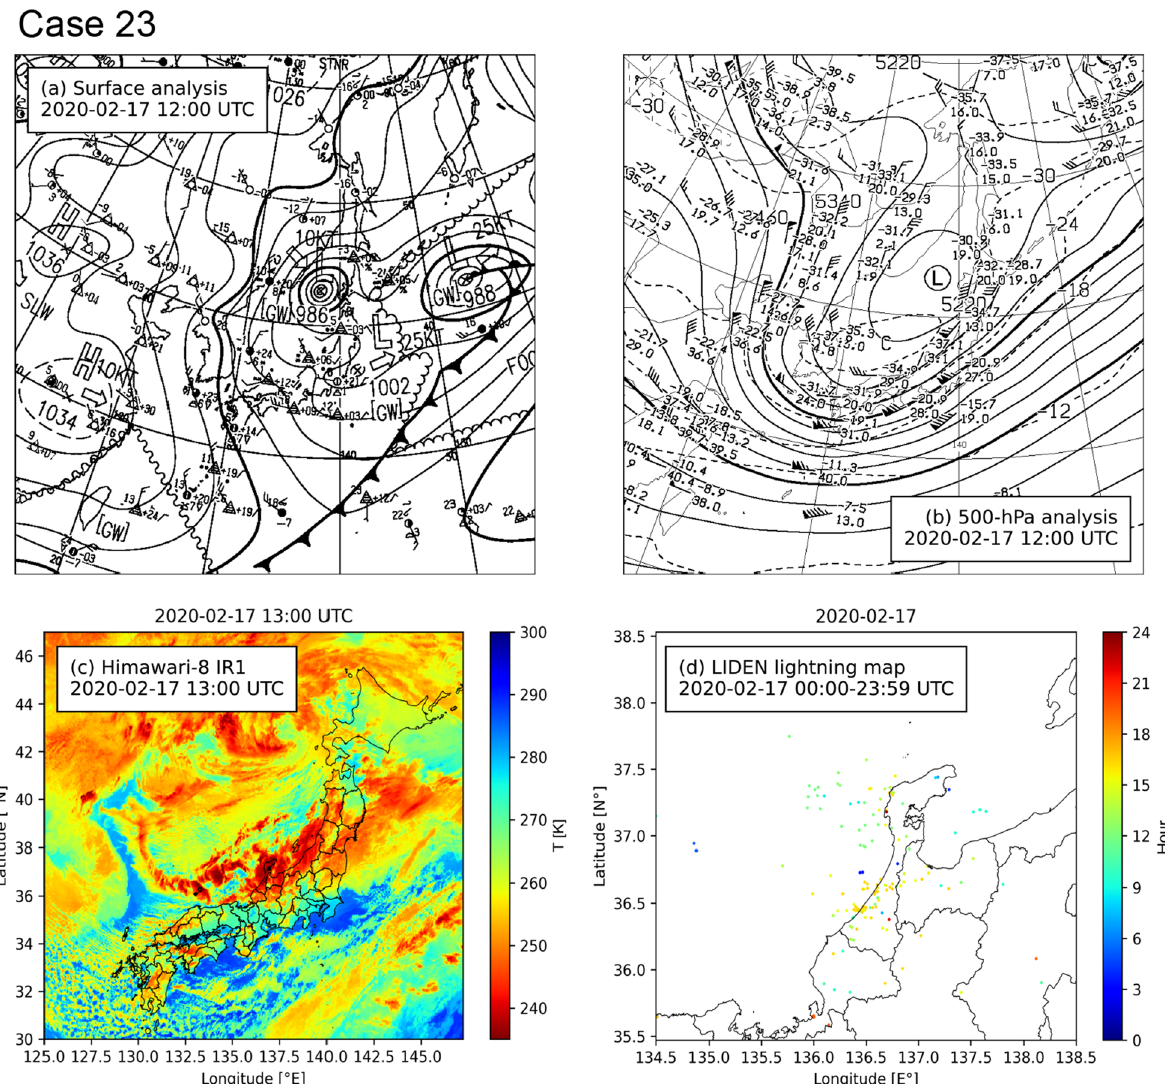
Fig. 5 Meteorological charts of the glow-detection Case 23 in the same format as Fig.